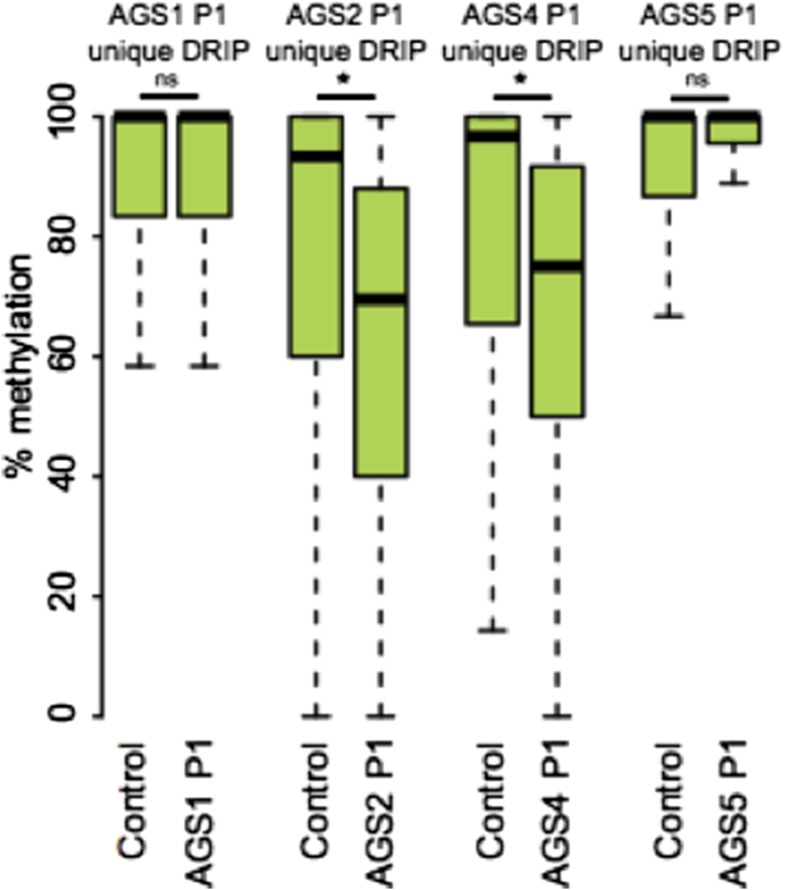
DOI:
http://dx.doi.org/10.7554/eLife.08007.020